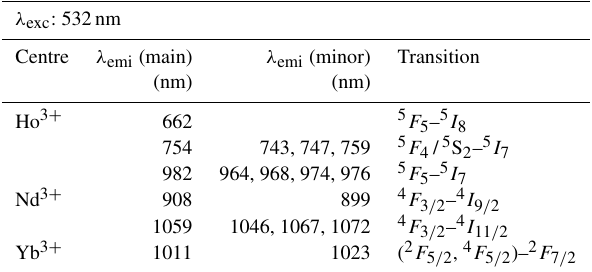
Table 4. Overview of detected emission lines and corresponding transitions for those REEs that were successfully excited with the 532nm